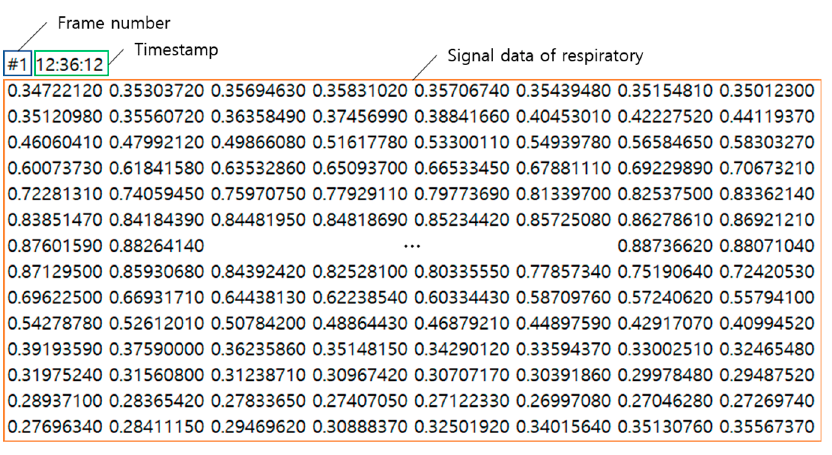
Figure 14. Construction of learning data by various time-shifting in one breathing pattern. In addition, the number of people who participated in the data collection totaled 10, and each target’s age, height, weight, and five patterns of respiratory signal data were collected as shown in Table 7. And the total experimental data were collected by a total of 250 data per participant, 50 for each pattern. Thus, the total data is composed of 2500. The age group of volunteers is in their mid-20 s to early 40 s, who are roughly in the range of the average to obese South Korean physique. Table 7. Data provider’s body information and five respiration patterns. Volunteer